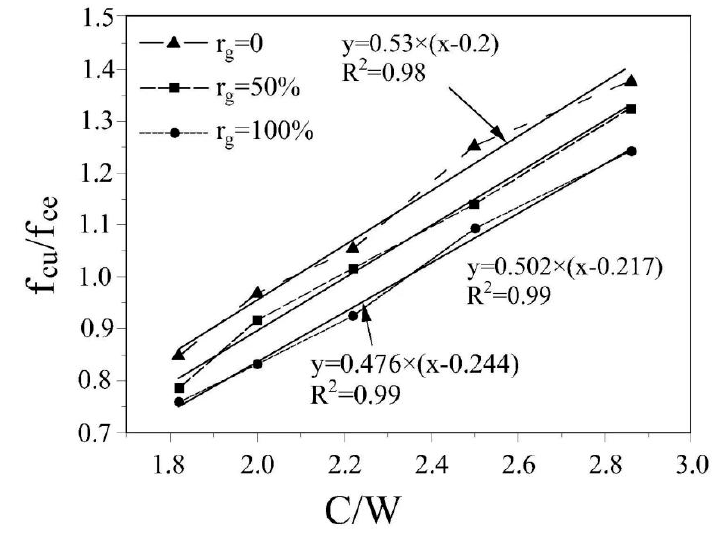
Figure 6. Fitting of the water-cement ratio of steel fiber recycled concrete